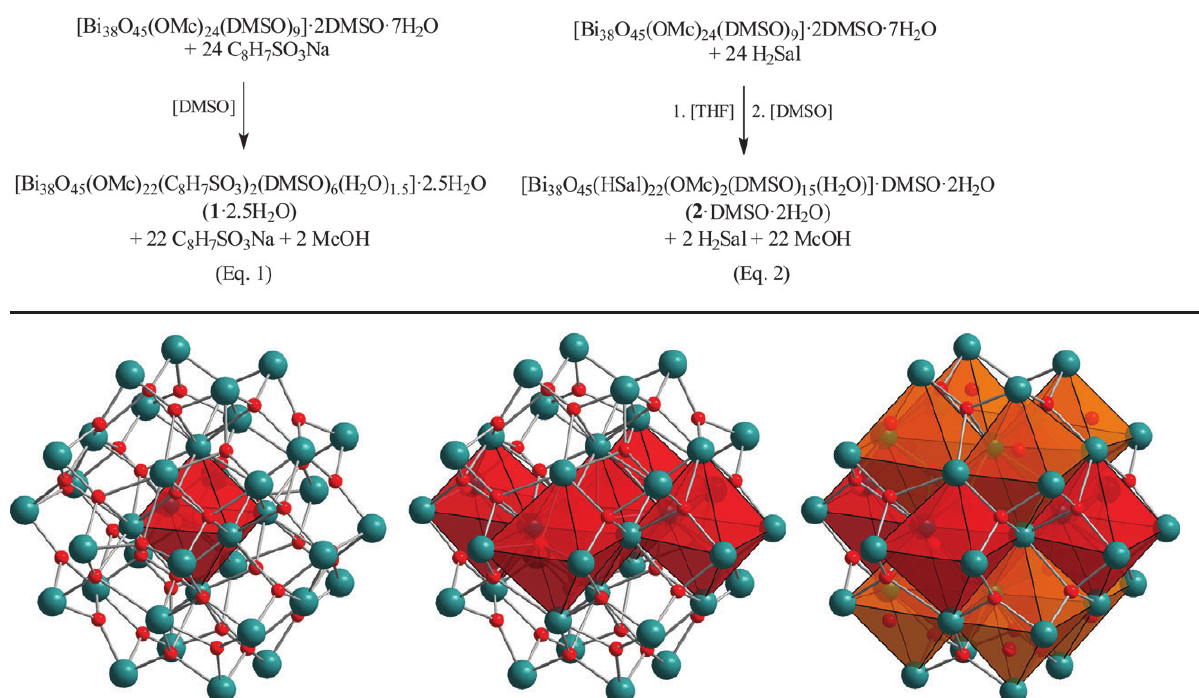
Figure 1 Assembly of the bismuth-oxygen core structure in [Bi